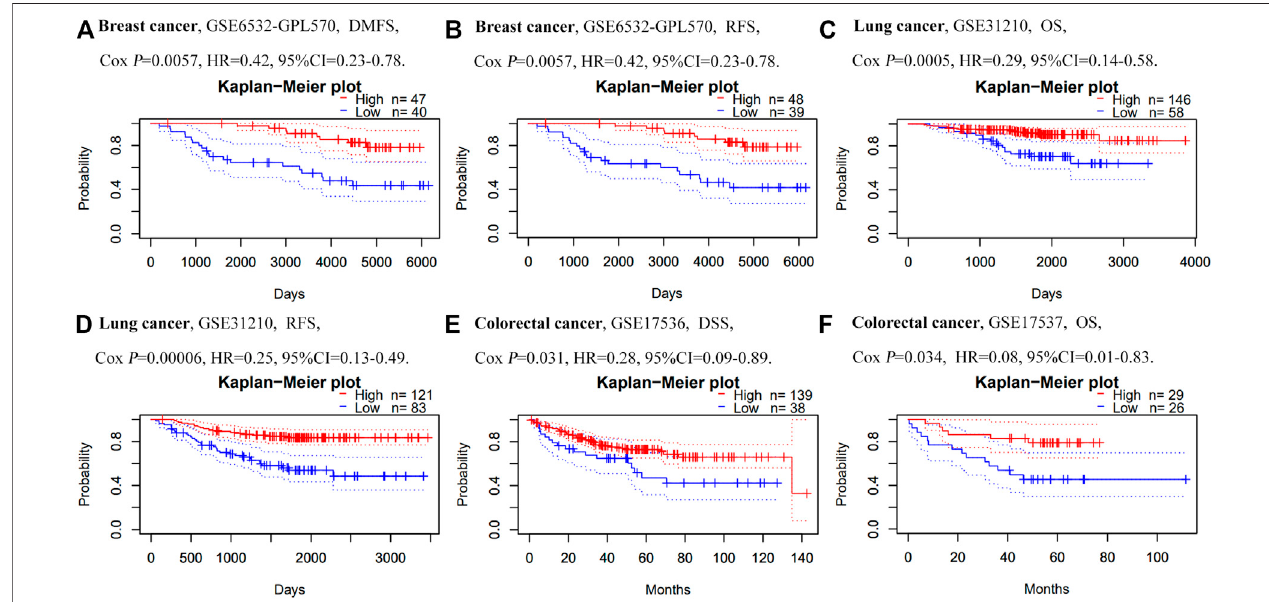
FIGURE 6 | Association of GNG7 mRNA expression with prognosis in different human cancers in the PrognoScan. (A – B) Survival curves of DMFS and RFS in a breastcancercohort(GSE6532-GPL570, n = 87). (C – D) SurvivalcurvesofOSand RFS in alung cancercohort(GSE31210, n =204). (E – F) Survivalcurves ofDSSand OS in two colorectal cancer cohorts [GSE17536 ( n = 177) and GSE17537 ( n = 55)].